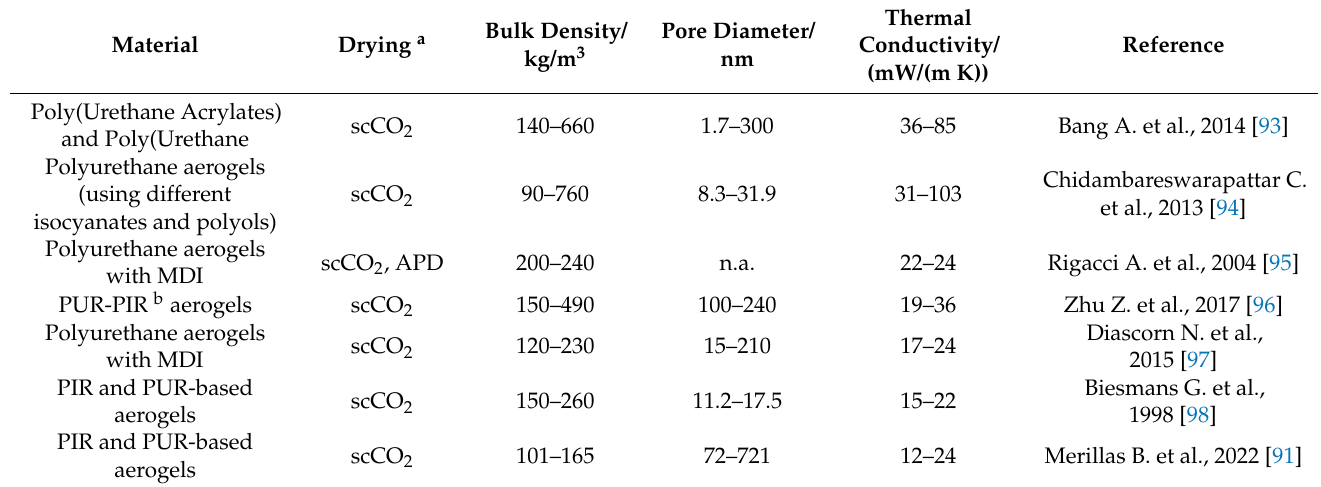
Table 5. Highly insulating polyisocianurate-polyurethane-based aerogels reported in the